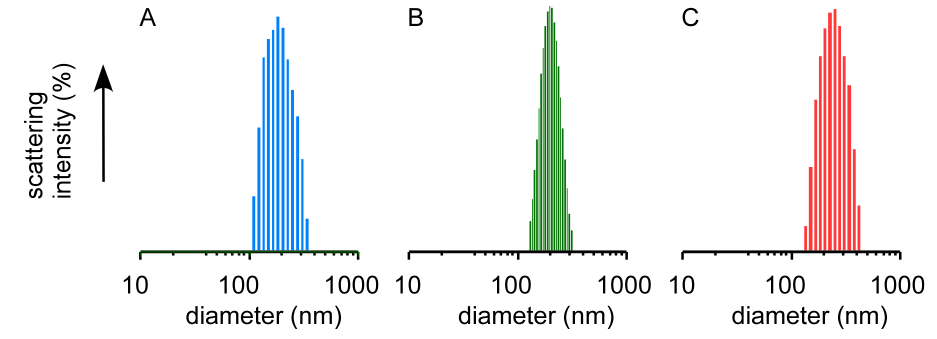
O and nanocapsules ( C ) in H 2